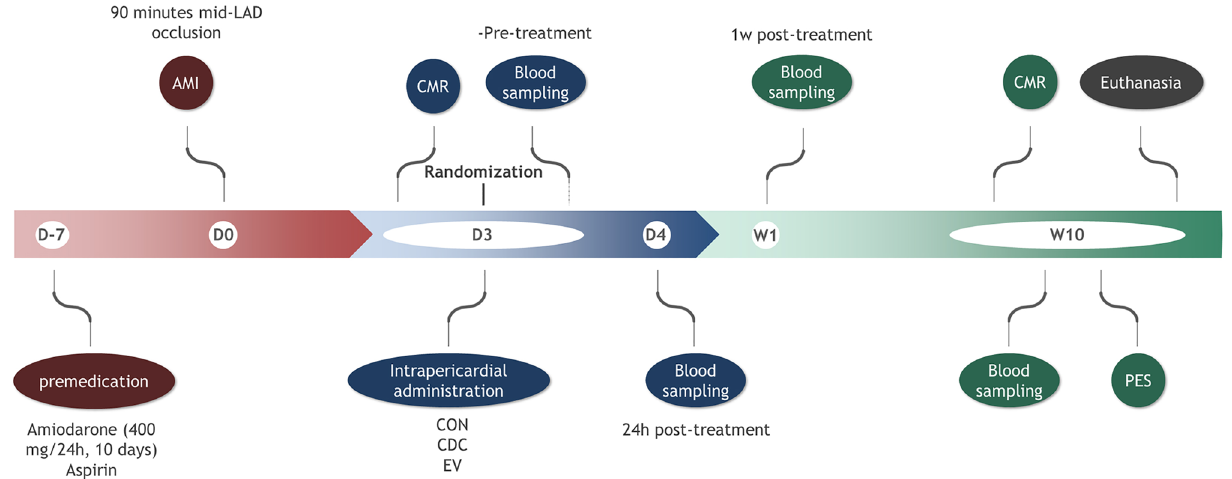
Figure 1. Large animal experimental workflow. Flow chart illustrating the study design in Large White swine. AMI acute myocardial infarction, CON control group, CDC cardiosphere-derived cells group, EV extracellular vesicles group, LAD left anterior descending coronary artery, CMR cardiac magnetic resonance, PES programmed electrical